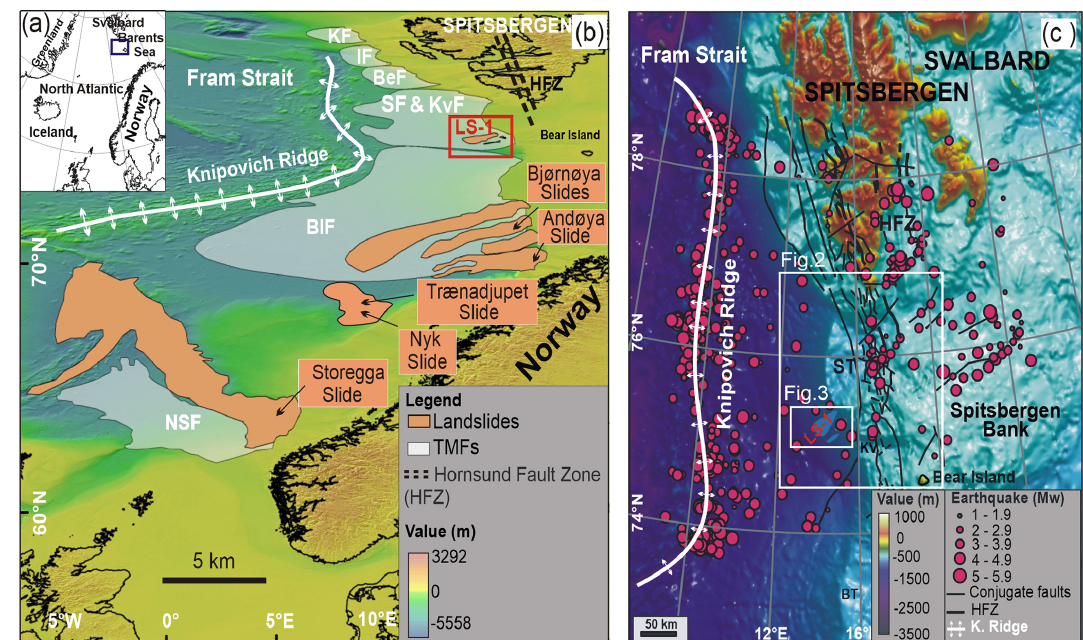
Figure 1. Geographic and geological settings of Storfjorden LS-1. (a) Location map of the study area (blue rectangle). (b) Shaded relief map taken from the International Bathymetric Chart of the Arctic Ocean (IBCAO) version 3.0 (Jakobsson et al., 2012) of the North Atlantic Ocean (Norwegian and Barents seas). The major trough mouth fans (grey polygons) and the major submarine landslides (orange polygons) are located on the map. Compilation from Haflidason et al. (2005), Laberg et al. (2000), Laberg and Vorren (1993), Lindberg et al. (2004), Sejrup et al. (2005), and references therein. KF: Kongsfjorden Fan; IF: Isfjorden Fan; BeF: Bellsund Fan; SF & KvF: Storfjorden Fan and Kveithola Fan; BIF: Bear Island Fan; NSF: North Sea Fan. (c) Shaded relief map of the northwestern Barents Sea (Ottesen et al., 2005) displaying the location of the Hornsund Fault Zone (HFZ) and the historical earthquakes recorded from 1960 to 2018 (source from IRIS catalogue; Incorporated Research Institutions for Seismology). This map also shows the locations of Figs. 2 and